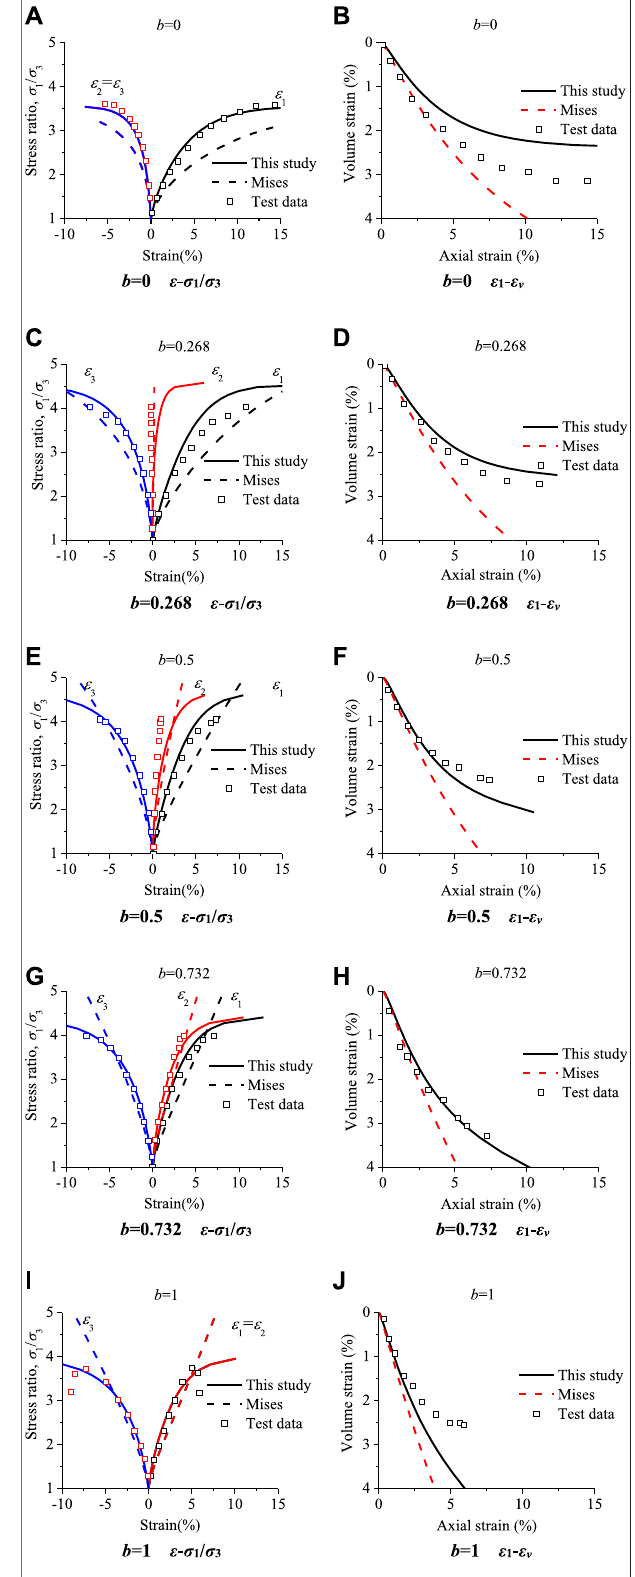
FIGURE 5 | Comparisons of the test results and predictions for true triaxial conditions (data from Nakai et al., 1986).